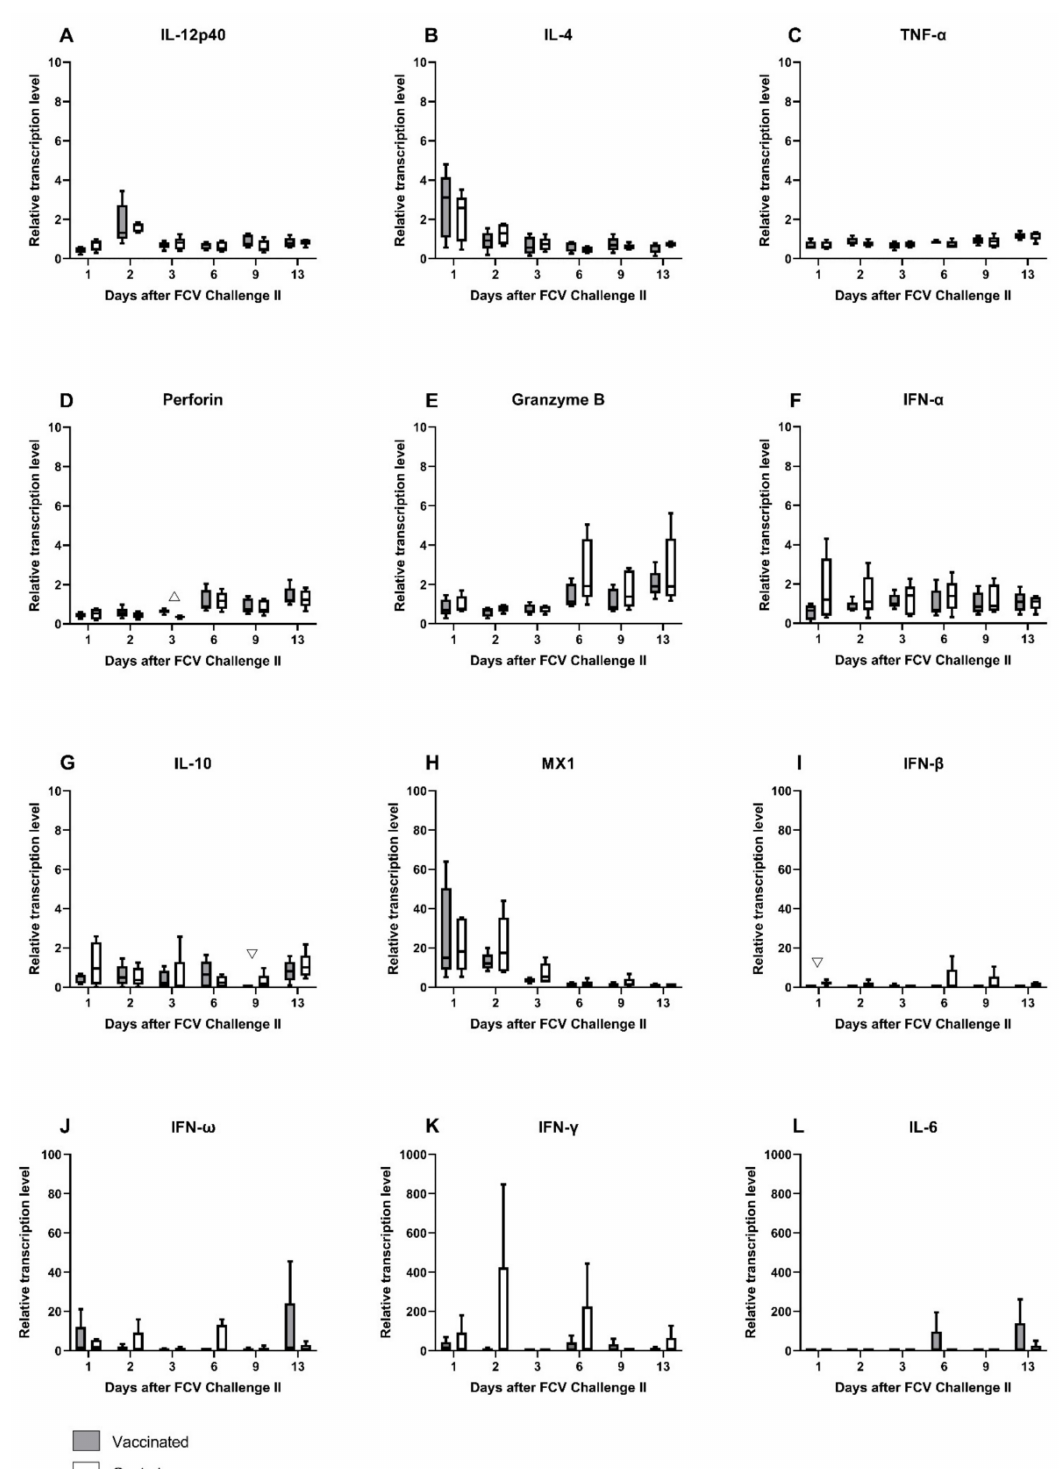
Figure 15. Box and whisker plots of cytokine expression profiles of IL-12p40 ( A ), IL-4 ( B ), TNF- α ( C ), perforin ( D ), granzyme B ( E ), IFN- α ( F ), IL-10 ( G ), MX1 ( H ), IFN- β ( I ), IFN- ω ( J ), IFN- γ ( K ) and IL-6 ( L ) after FCV Challenge II. The line inside the box shows the median, and the lower and upper border of the box indicates the 25th and 75th percentile, respectively. Whiskers represent minimum and maximum values. Significant differences between the vaccinated and the control group are indicated by open triangles; (cid:52) denotes significantly higher in the vaccine group P MWU ≤ 0.05; (cid:53) denotes significantly lower in the vaccine group P MWU ≤ 0.05. The y-axes are scaled to either 0–10, 0–100, or 0–1000 relative mRNA transcription levels, and the graphs are ordered,